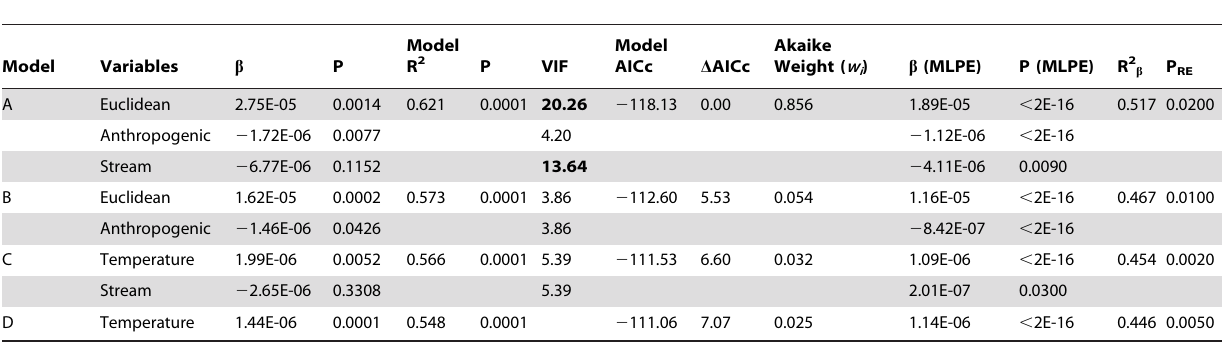
Table 3. Multiple regression on distance matrices (MRM) and maximum likelihood population effects (MLPE) results showing the relationship between pairwise genetic distance (linearized D est ) and least-cost path cost distances incorporating landscape